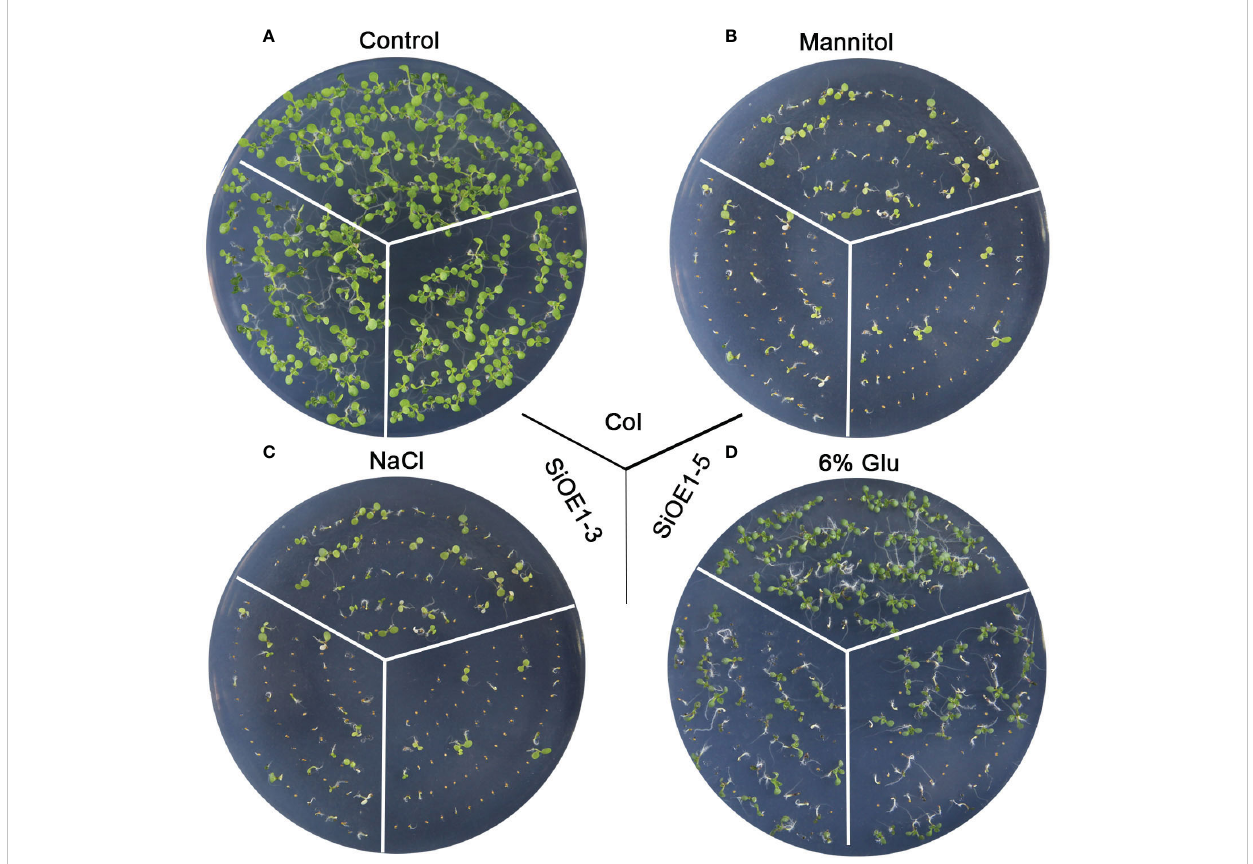
FIGURE 8 Phenotypic analysis of SiNCED1 transgenic plants under MS, mannitol, NaCl and Glucose. (A – D) The phenotype of Col and SiNCED1 transgenic seeds grown in MS (control), MS contain 275 mM Mannitol, 150 mM NaCl or 6% Glucose, respectively for 7